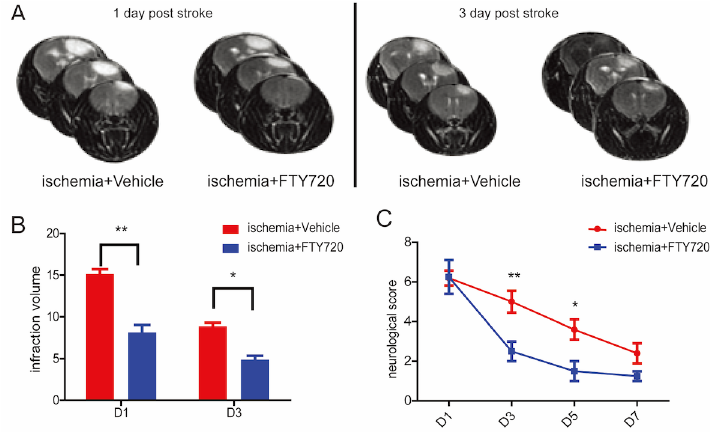
Fig 1. FTY720 alleviates ischemic brain damage and improves functional recoveryfollowing cerebral ischemia. A, Representative MRI images for the ischemia+vehicle treatment groupand ischemia+FTY720 treatment groupat 1 day (left) and 3 days (right) after photothrombotic ischemia. B, Reduced infarctionvolume was assessed by MRI examinationafter treatment with FTY720 at 1 day and3 days post photothrombotic injury. C, Neurologicaldeficiencywas evaluated at 1, 3, 5, and7 days post ischemia. Valuesare expressedas mean ± SEM and data wereevaluatedby the Student’st test (n = 6, * p < 0.05vs. ischemia+vehicle group, ** p < 0.01vs. ischemia+vehicle